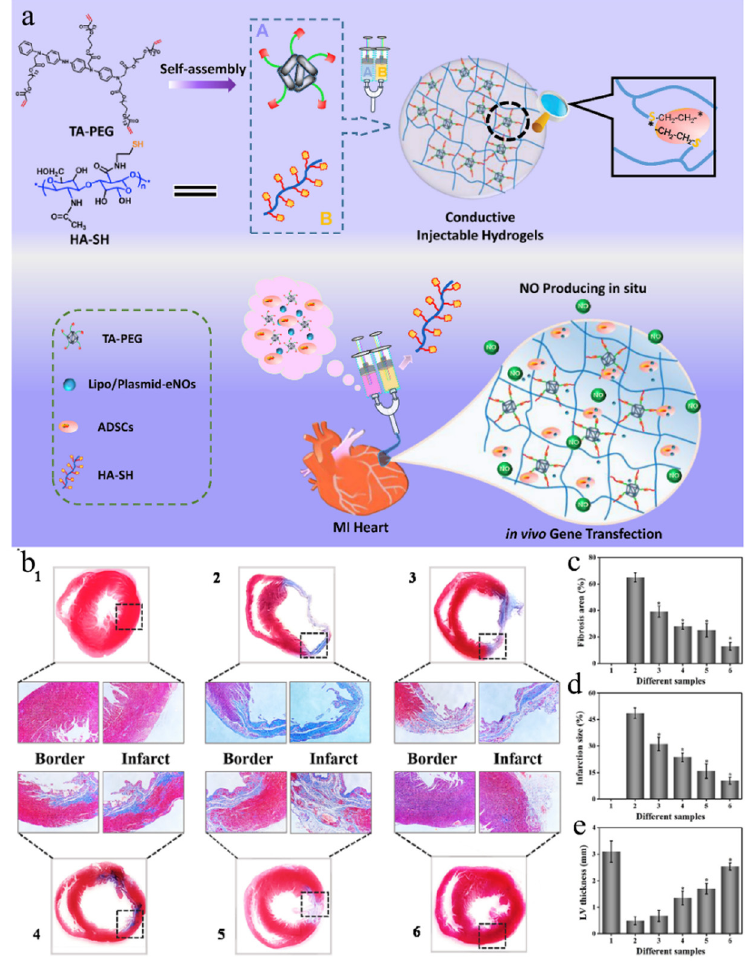
Figure 6. ( a ) Schematic diagram of an injectable conductive hydrogel loaded with plasmid DNA-eNOs nanoparticles and ADSCs for treatment of myocardial infarction. In this design, (1) the conductive hydrogels would enhance the electrical communications to restore the heart functions; (2) ADSCs encapsulated in hydrogels can be directly injected into the infarcted myocardium to alleviate the inflammation environment and compensate the cell loss after MI; (3) the up-regulated eNOs expression in myocardium tissue would promote neo-vascularization and enhance the mature of myocardium. ( b ) Cardiac structures in the six groups as revealed by Masson’s trichrome straining and quantitative analysis of fibrosis area ( c ), infarct size ( d ), and LV thickness ( e ). ( 1 ) Normal; ( 2 ) MI; ( 3 ) PEG-4A/HA-SH; ( 4 ) TA-PEG/HA-SH ; ( 5 ) TA-PEG/HA-SH/ADSCs; ( 6 ) TA-PEG/HA-SH/ADSCs/Gene; (Reprinted with permission from Ref. [196]. 2022, Elsevier).